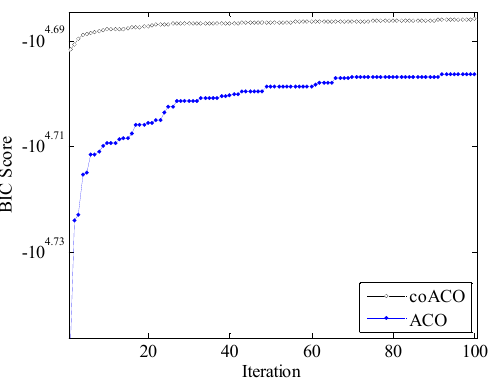
Figure 10. Evolution curves of the average BIC score achieved by ACO and coACO on the ALARM dataset with n = 5000.